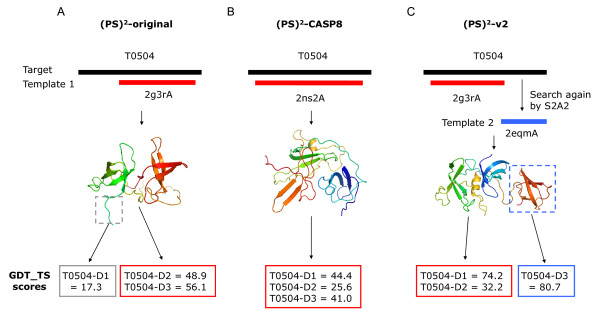
Comparison the (PS)2-v2 server with (PS)2-original and (PS)2-CASP8 servers on the target T0504 in CASP8. The (PS)2-CASP8 server uses human spindlin1 (PDB code 2ns2) as the template, conversely, (PS)2-v2 utilizes a multiple-template strategy and selects both 53BP1 tandem tudor domains (PDB code 2g3r) and PHD finger protein 20-like 1 (PDB code 2eqm) as templates. (PS)2-v2 significantly outperforms (PS)2-CASP8 on the T0504-D1 and T0504-D3 domains.